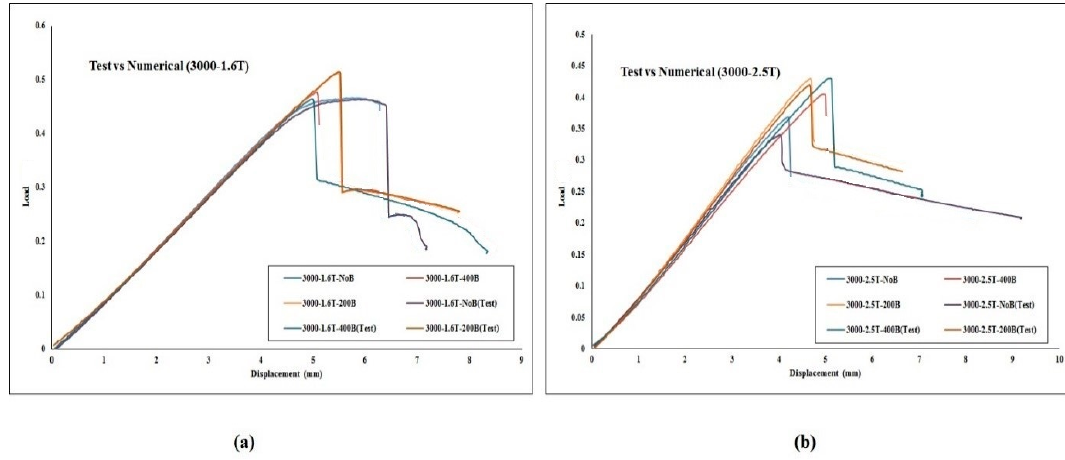
Figure 9. Comparison of experimental and numerical results of normalised load for ( a ) 3000L-1.6T, ( b ) 3000L-2.5T.